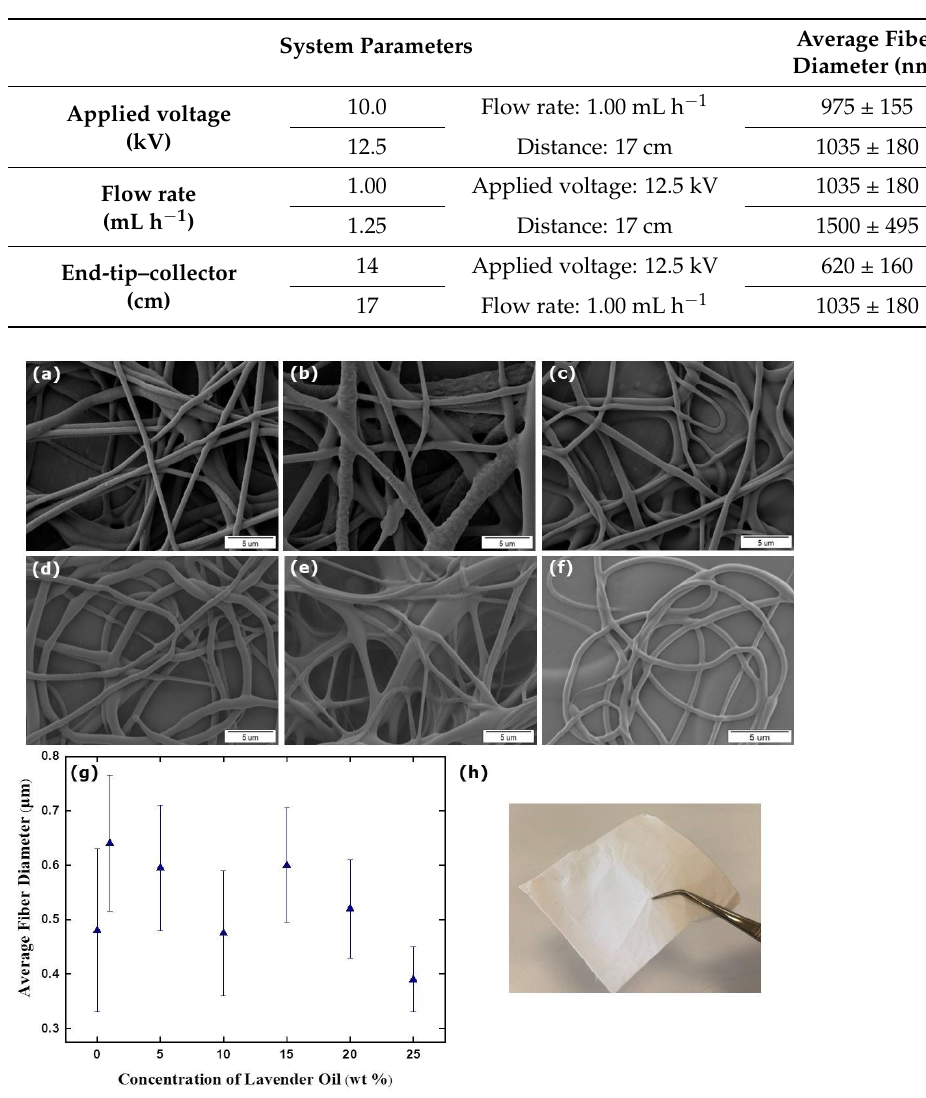
Table 3. The effect of system parameters applied for the fabrication of TPU fibers containing 20 wt % SJWO on the diameter.